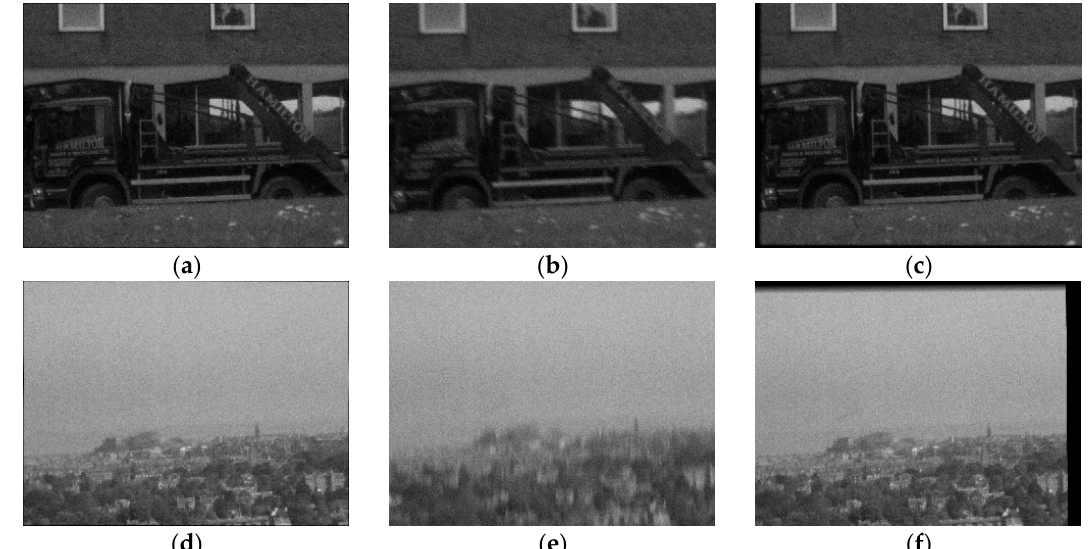
Figure 10. Results of camera shake test, in terms of video-rate image frames (each composed from N = 250 bit-planes): ( a ) truck, still camera; ( b ) truck, shaken camera ( R = 0.79); ( c ) compensated version of image b ( R = 0.99); ( d ) skyline, still camera; ( e ) skyline, shaken camera ( R = 0.75); ( f ) compensated version of image of d ( R = 0.96). R is the 2D correlation coefficient with respect to the image from the still camera (obtained with a tripod).